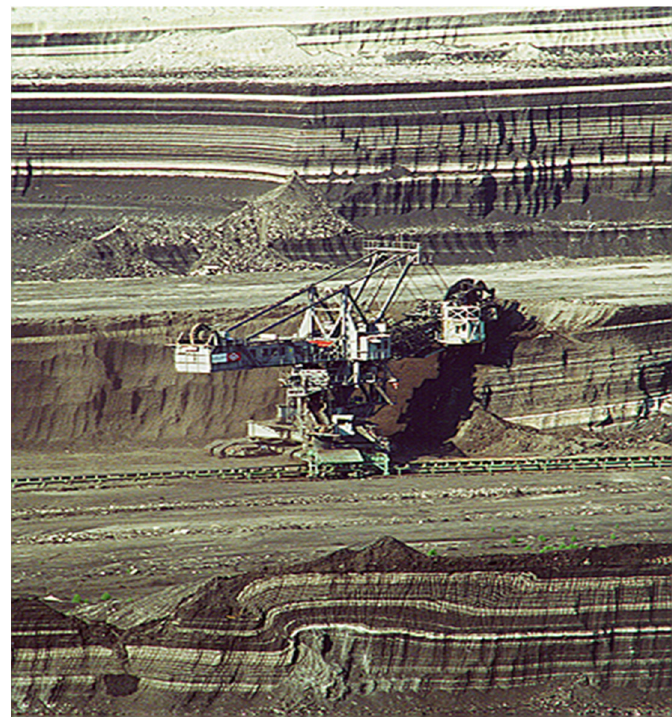
Figure 1. Multiple-layered structure of Greek lignite deposits.